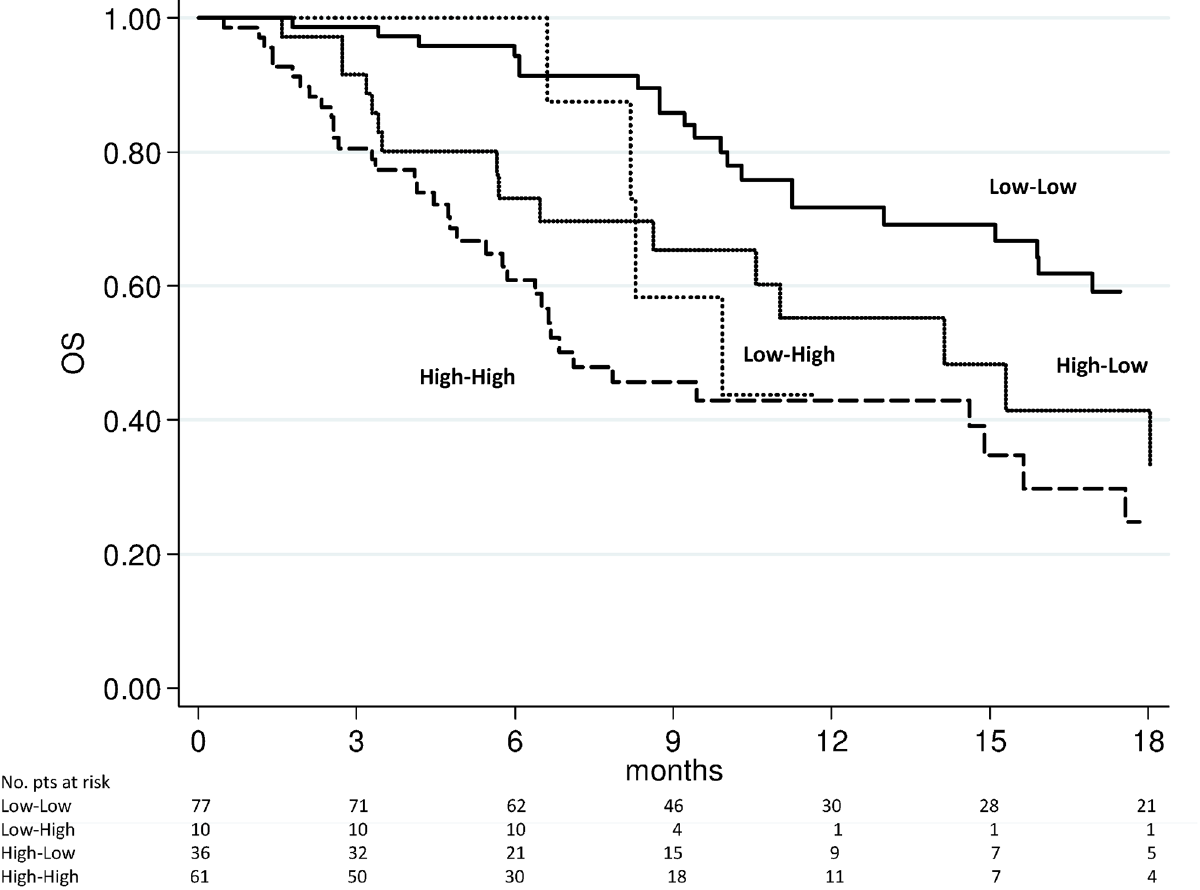
Fig 5. Overall survival according to pre-therapy and follow-up NLR at 4 weeks of enzalutamide treatment.